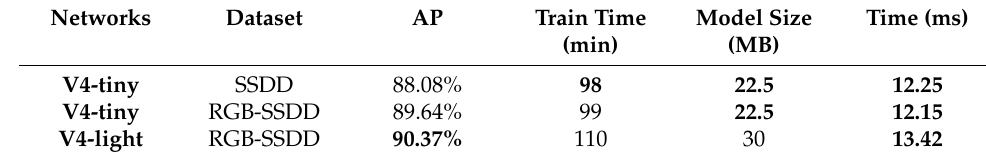
Table 5. Ship detection performance with different datasets and network architectures.